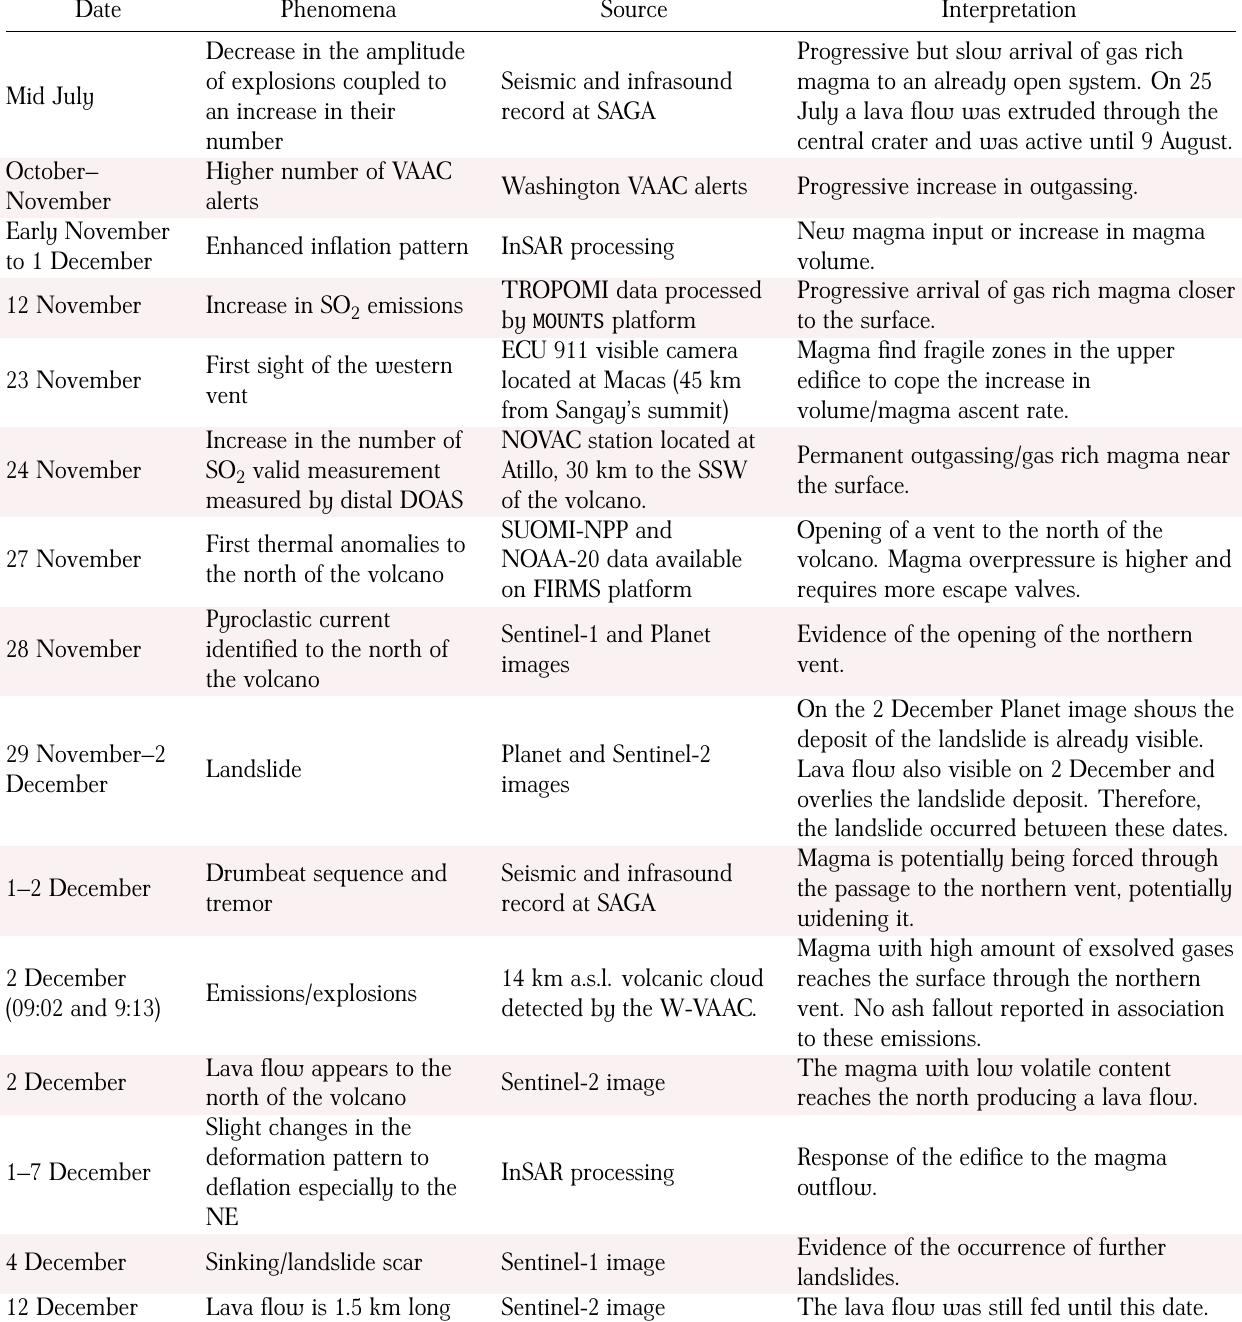
Table 1: Sequence of parameters measured and observed during the analyzed period including the corresponding source and